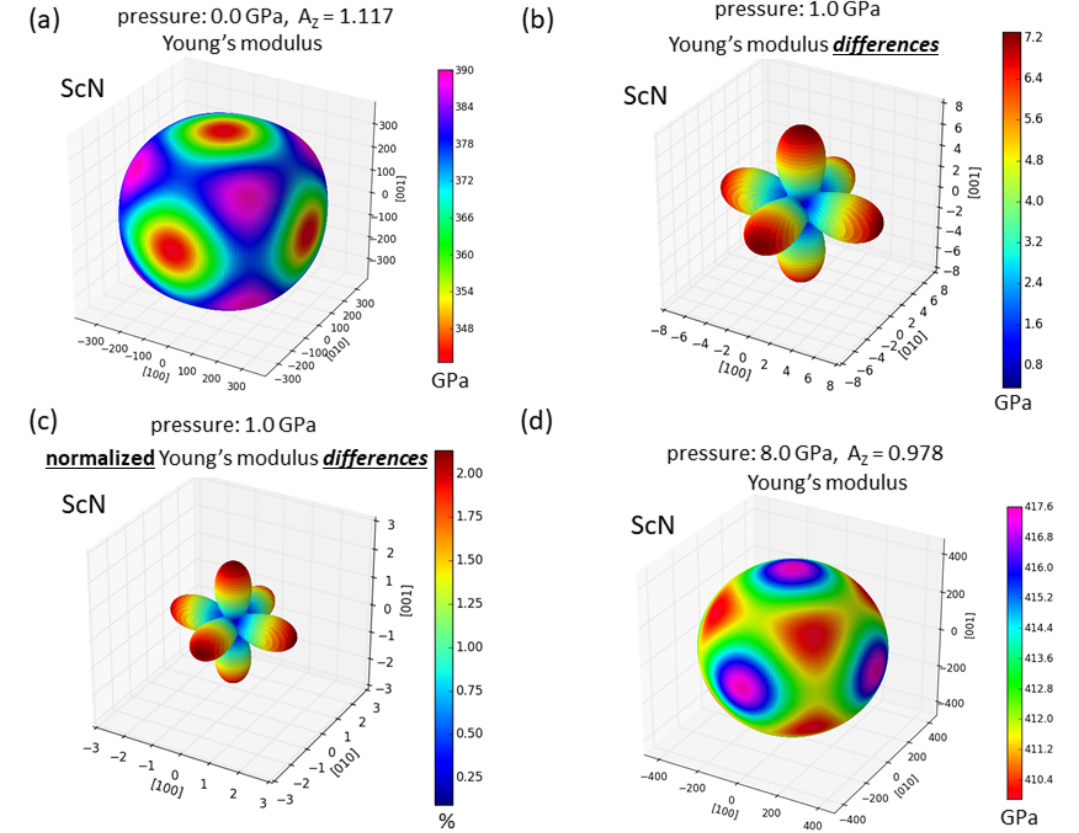
Figure 3. The same as in Figure 2 but for ScN. Part ( d ) is computed at the hydrostatic pressure of 8.0 GPa. The parts ( a ) and ( d ) were visualized by the SC-EMA [42–44] library (scema.mpie.de) based on our ab initio computed elastic